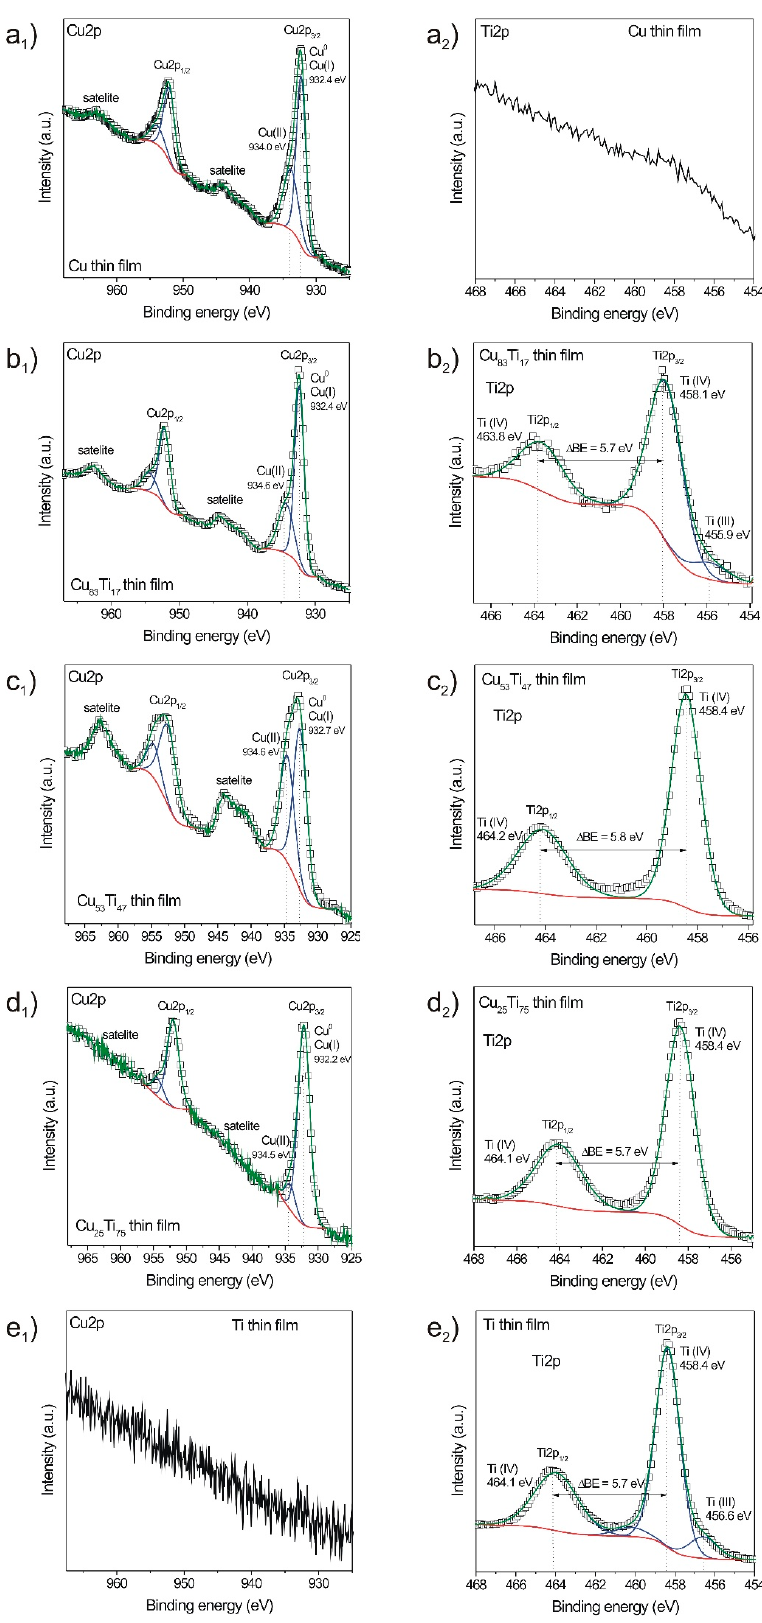
Figure 4. XPS spectra of nanocrystalline coatings: ( a ) Cu, ( b ) Cu 83 Tu 17 , ( c ) Cu 53 Ti 47 , ( d ) Cu 25 Ti 75 , and ( e ) Ti. Designations: (1) Cu2p state, and (2) Ti2p